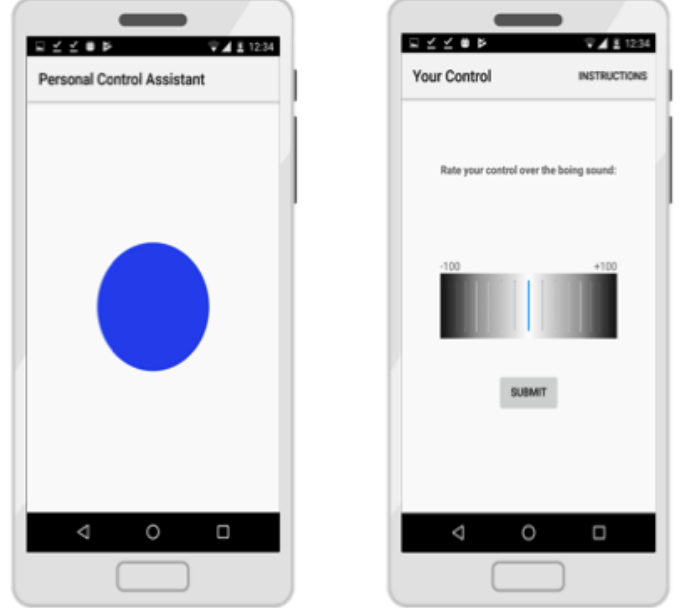
Figure 2. Contingency judgment task implemented as user-phone interactions, including action and auditory outcome stimulus, with control ratings given after every block of 8 interactions